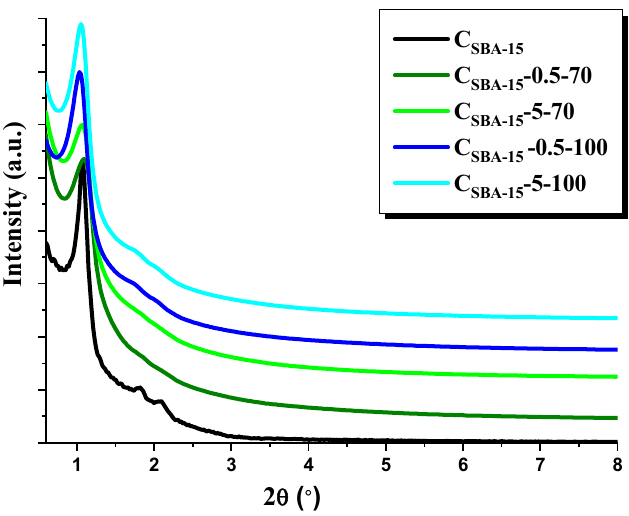
Figure 1. XRD patterns of adsorbents obtained.